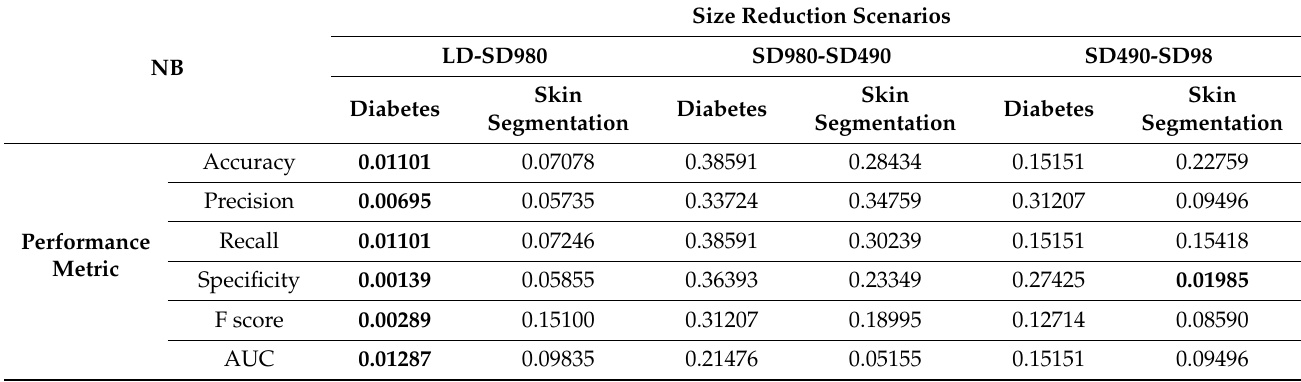
Table A11. p -values for different size reduction scenarios using the NB model; bold values are